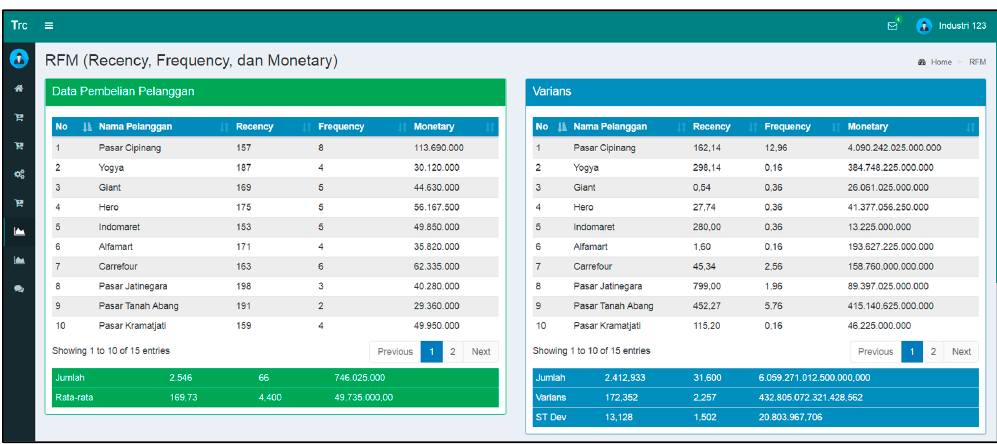
Figure A3. Interface on the product testing form.